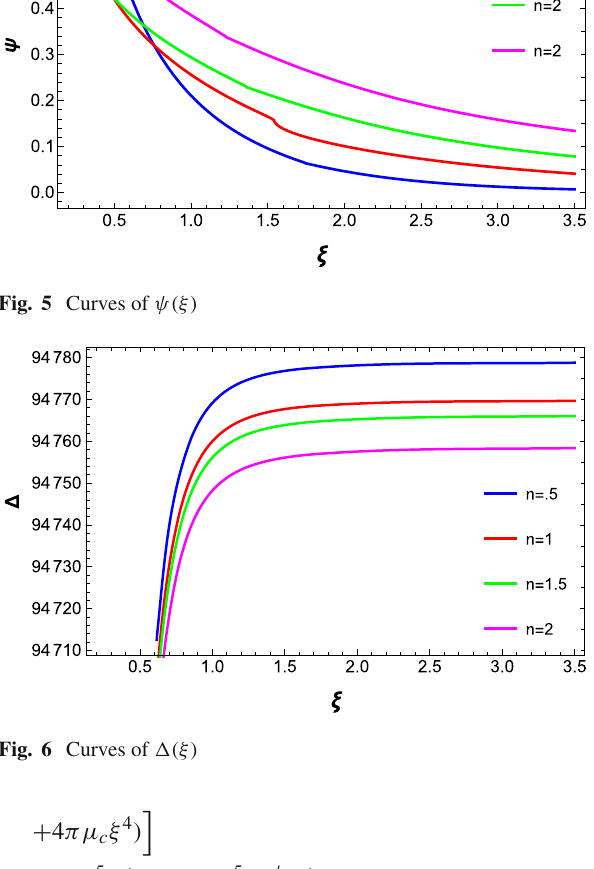
Fig. 2 Curves of ψ o (ξ)